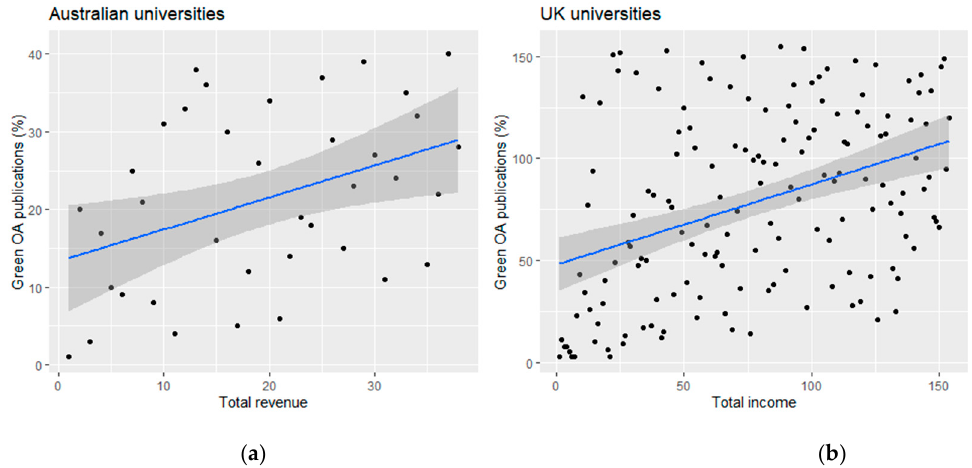
Figure A2. Scatterplot shows correlations between percentages of Green (repository) OA publica-